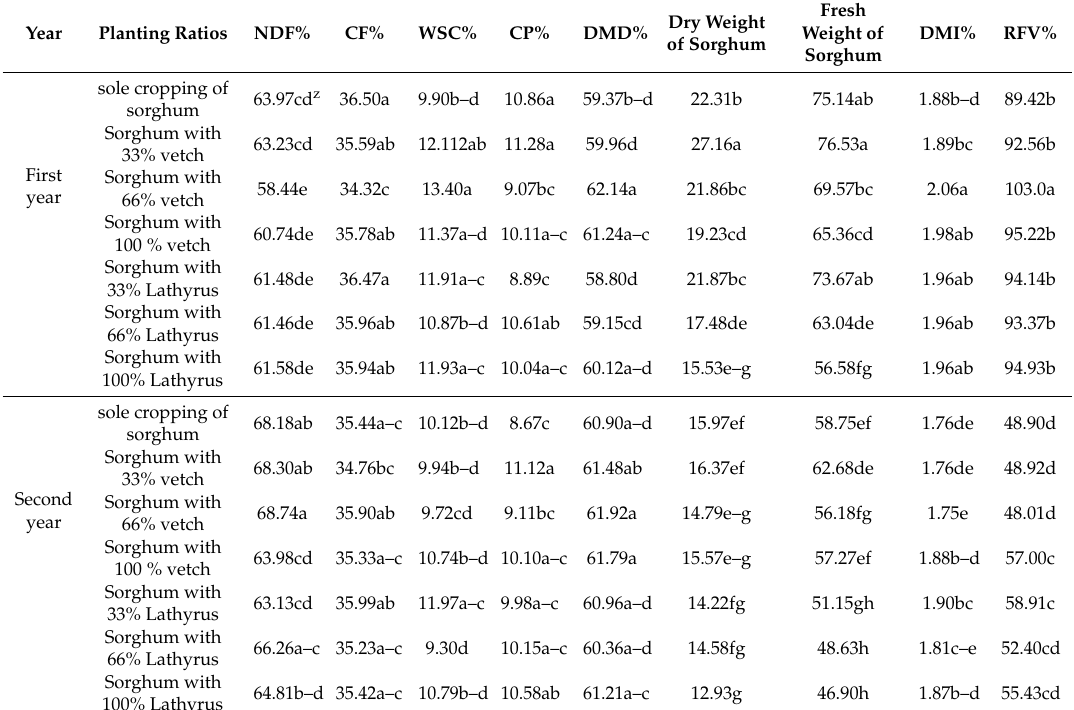
Table 4. Interaction e ff ect of year and intercropping on quantitative and qualitative traits of sorghum in 2015 and 2016.